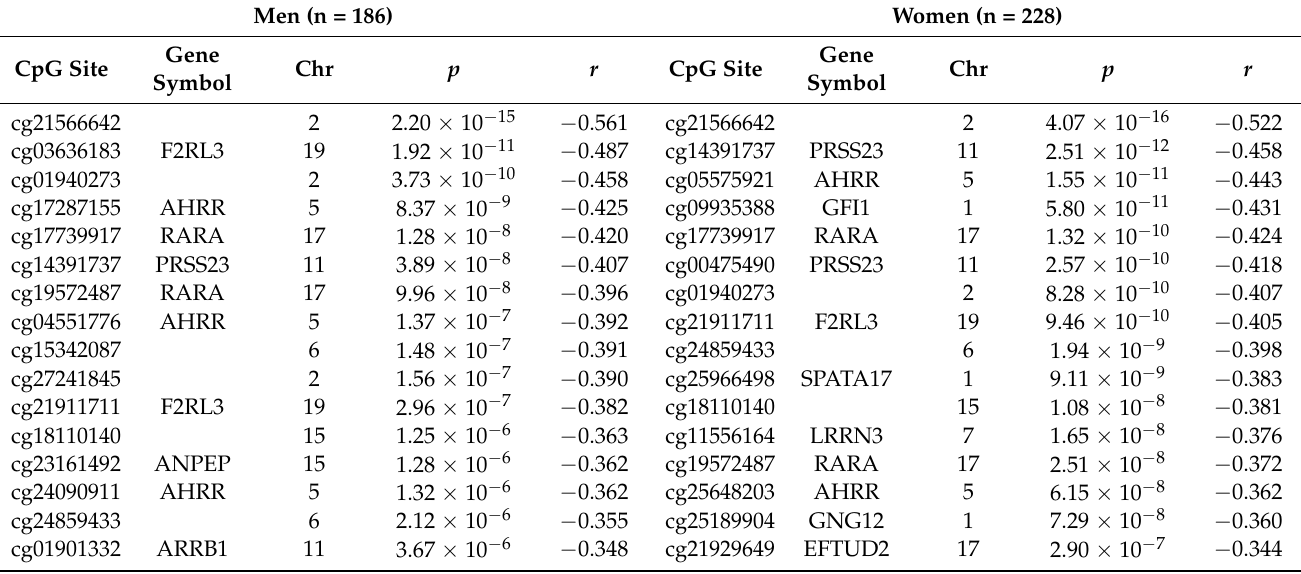
Table 6. Top differentially methylated CpGs for the epigenome-wide methylation analysis of tobacco smoking status (5 levels) 1 , in men and women, after multivariate adjustment 2